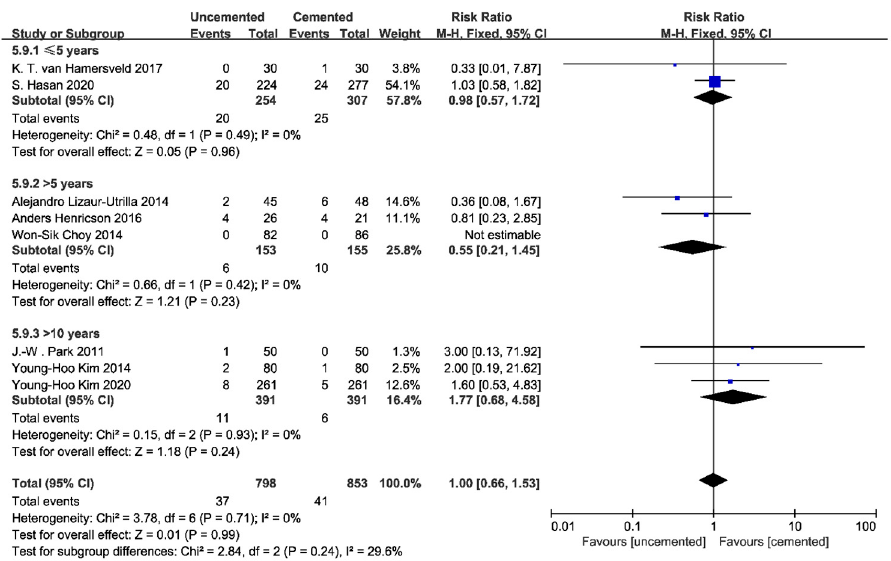
Figure 7. Forest plot of revisions by time